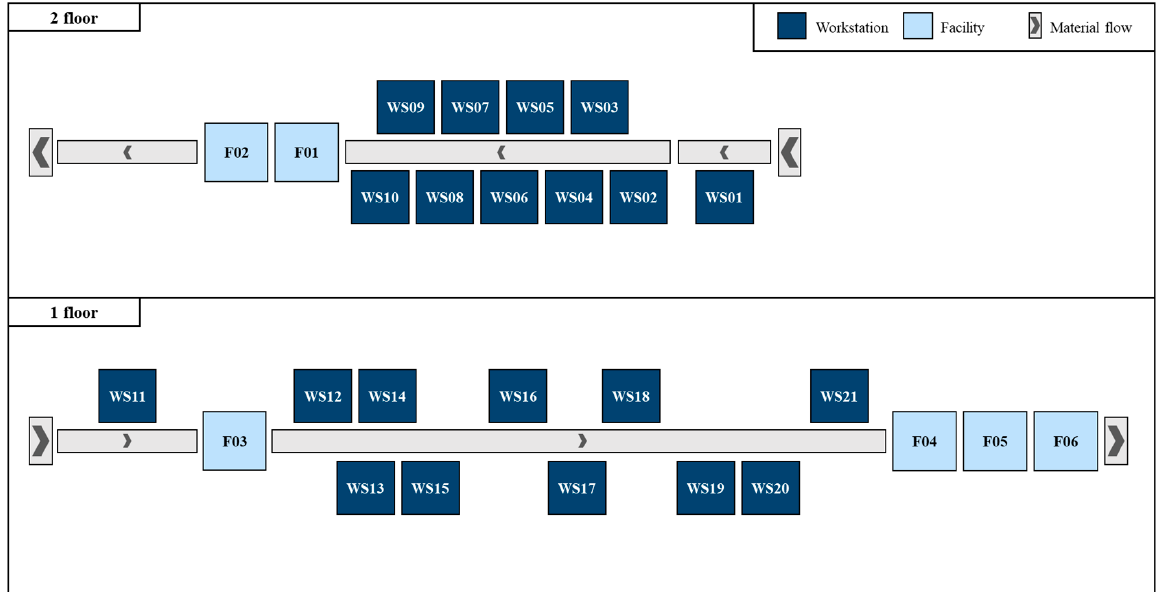
Figure 5. Layout image of the as-is scenario. Table 3. Process and sequence information of the as-is scenario.